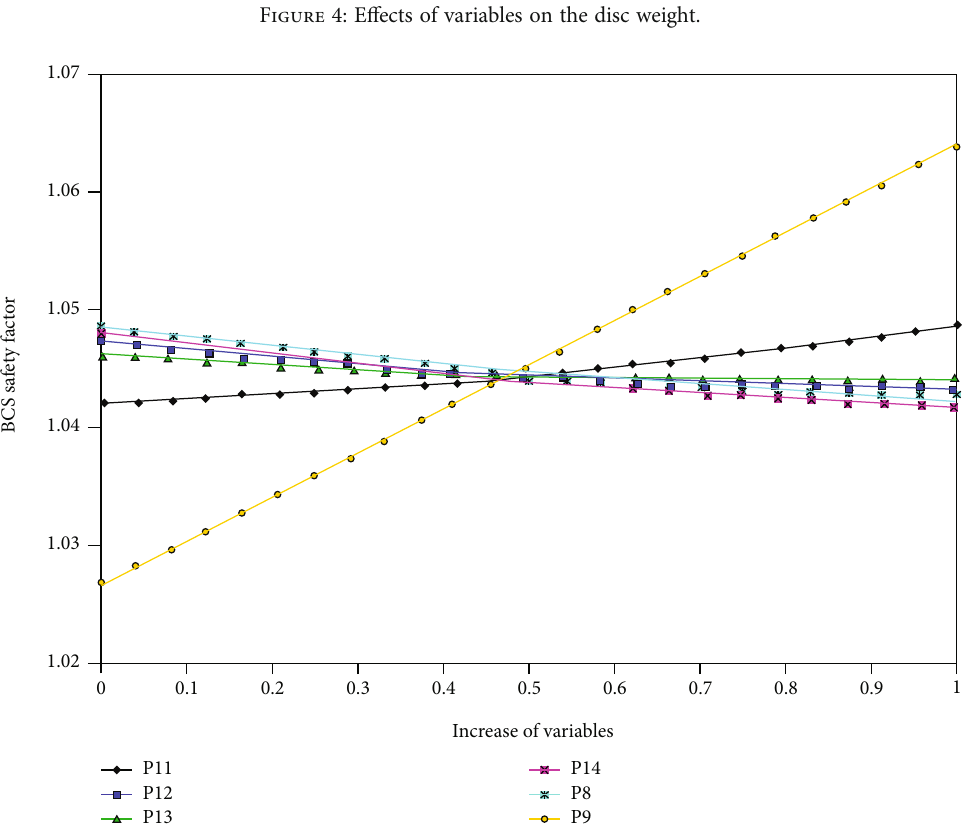
Figure 5: E ff ects of variables on the BCS safety